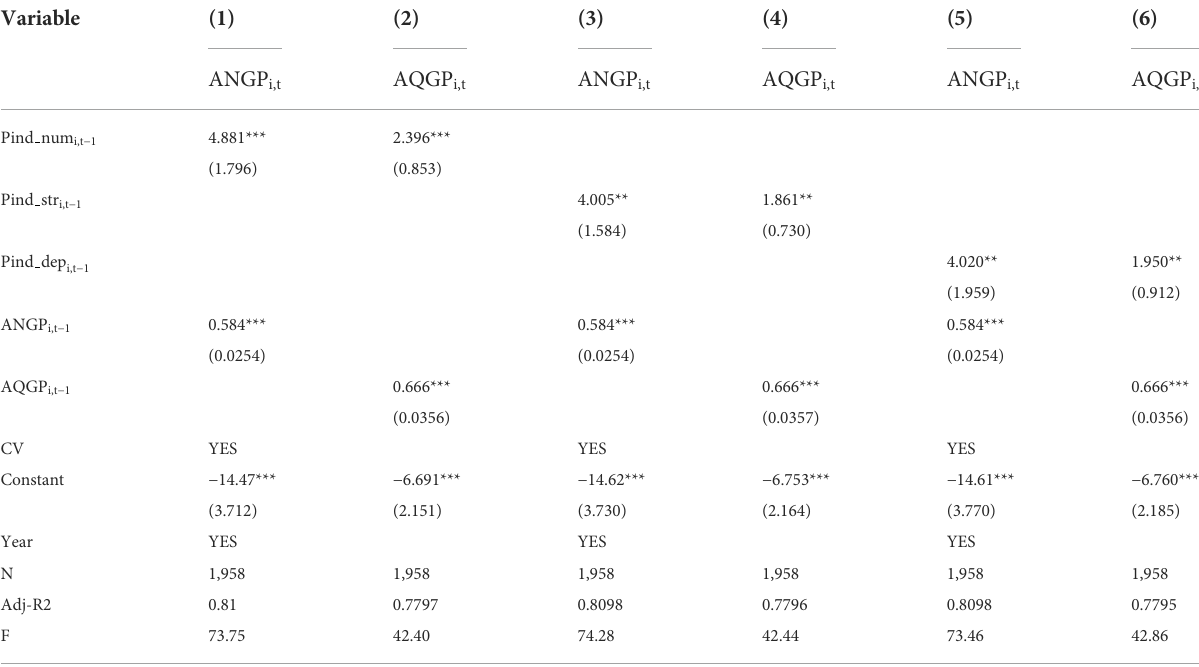
TABLE 7 Test results for the impact of heterogeneous environmental administrative penalty on the peer enterprises ’ GTI.